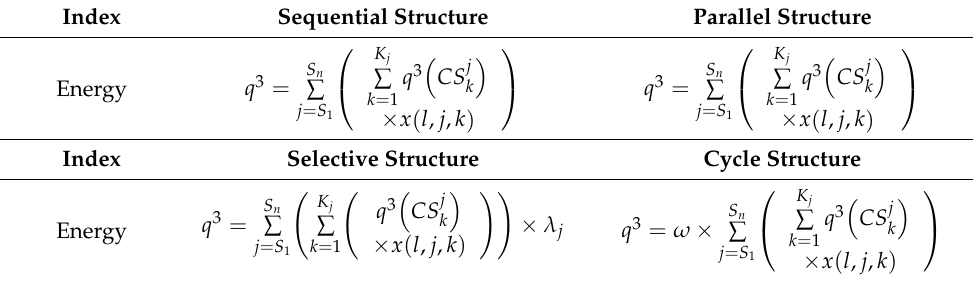
Table 9. QoS expressions of internal composite (Energy).